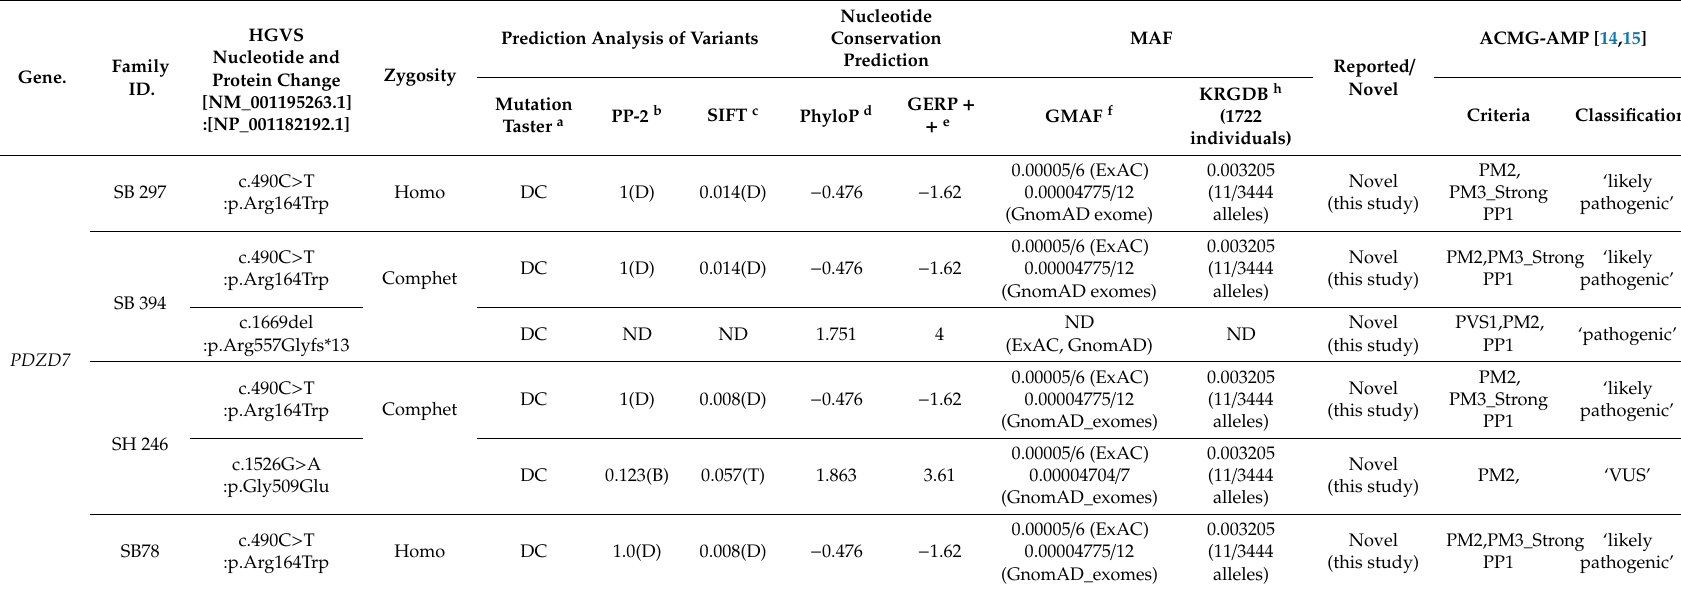
Table 1. Pathogenic variants of PDZD7 and its pathogenicity from four unrelated Korean